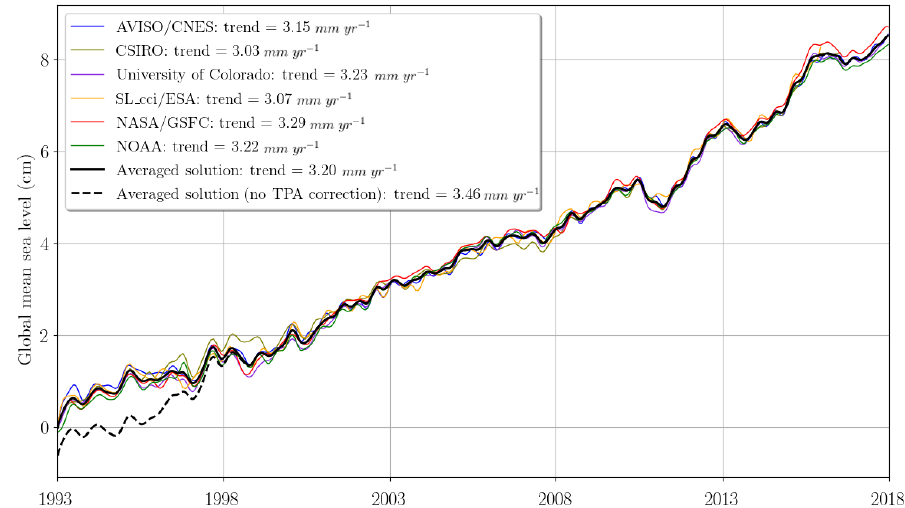
Figure 1. Evolution of GMSL time series (corrected for TOPEX-A drift using the Ablain (2017) TOPEX-A correction) from six different groups’ (AVISO/CNES, CSIRO, University of Colorado, SL_cci/ESA, NASA/GSFC, NOAA) products. The SL_cci/ESA covers the period from January 1993 to December 2016, while all other products cover the full 25-year period (January 1993 to December 2017). Seasonal (annual and semi-annual) signals have been removed and a 6-month smoothing has been applied. An averaged solution has been computed from the six groups. GMSL time series have the same average on the 1993–2015 period (common period) and the averaged solution starts at zero in 1993. The averaged solution without TOPEX-A correction has also been represented. A GIA correction of − 0 . 3mmyr − 1 has been subtracted from each data set. A correction of + 0 . 10mmyr − 1 due to the deformations of the ocean bottom in response to modern melt of land ice (Frederikse et al., 2017; Lickley et al., 2018) has also been